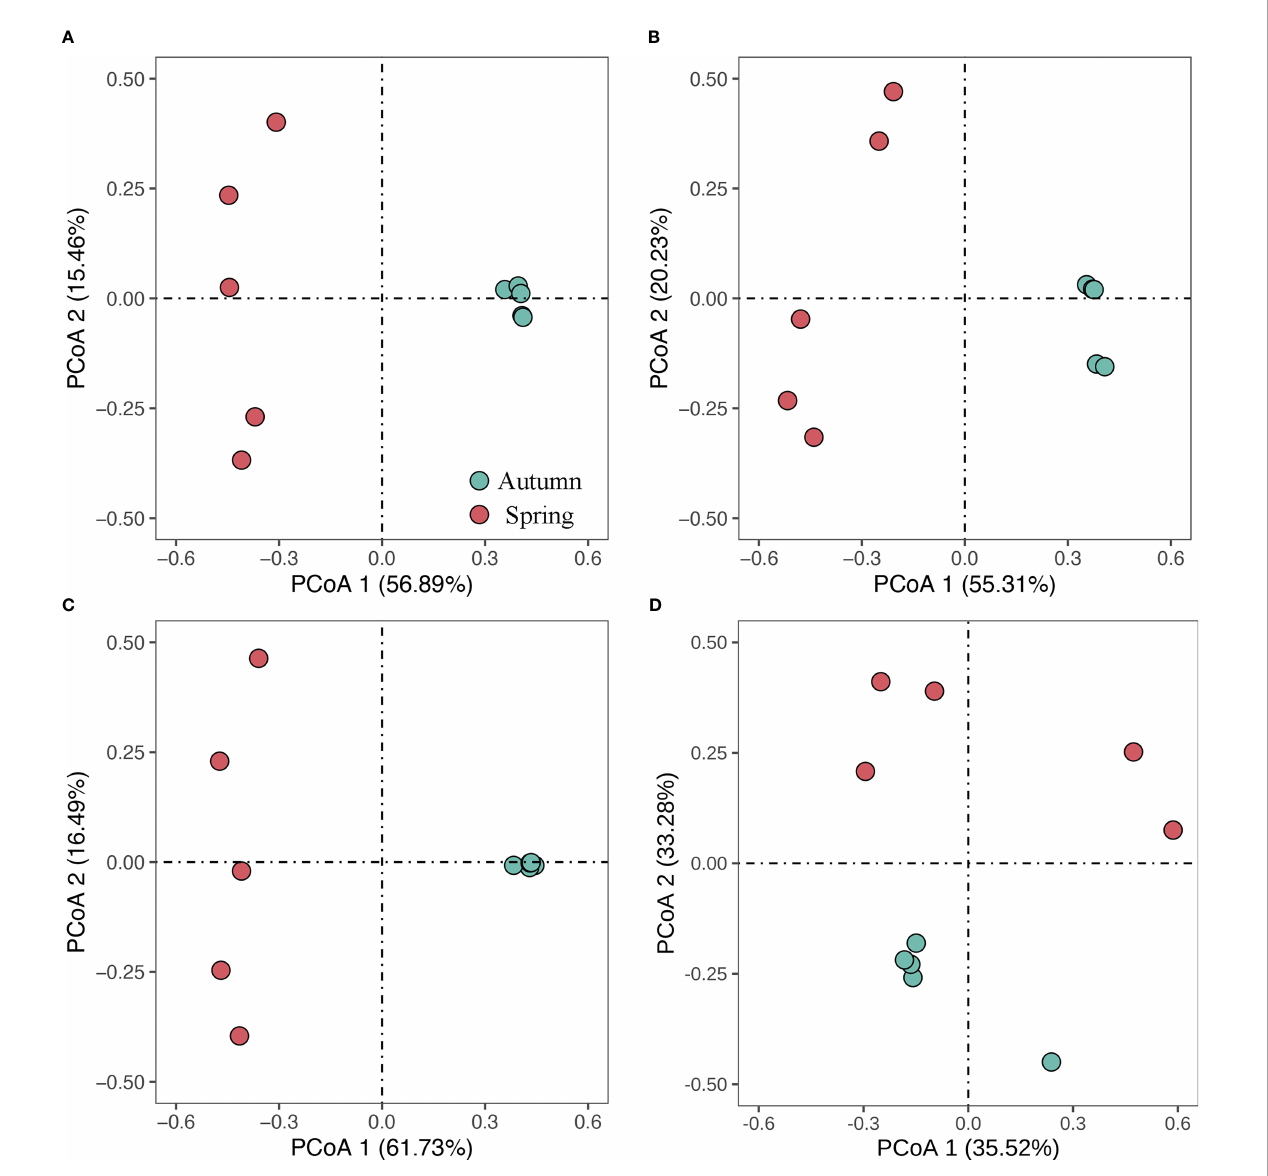
FIGURE 3 Biplot of principle coordination analysis showing the Bray-Curtis distance of community structure of (A) all species, (B) fi sh, (C) crustacean and (D) cephalopod between spring and